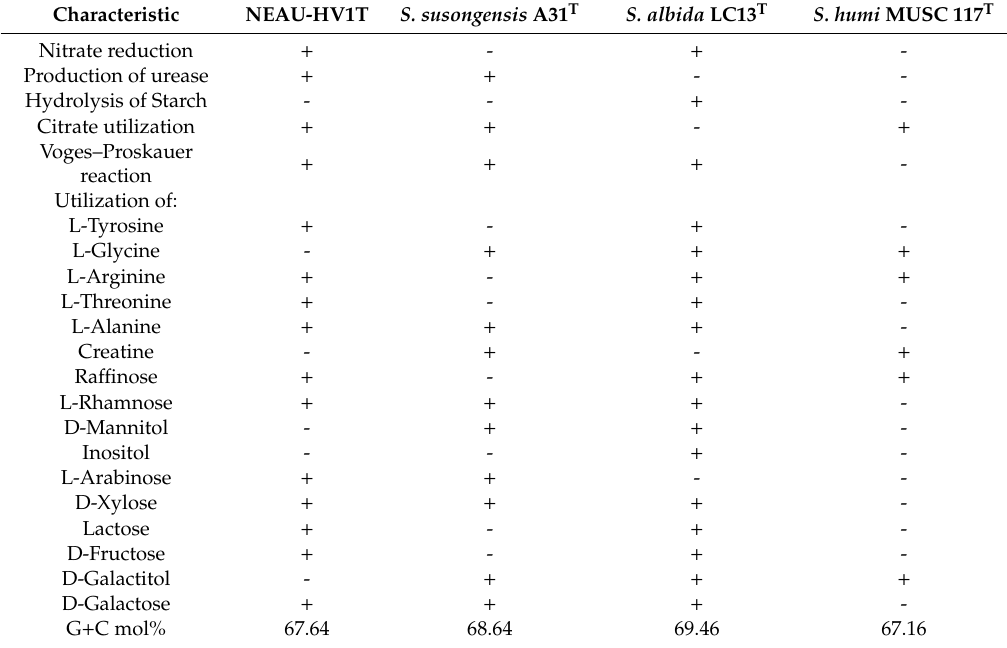
Table 1. Di ff erential characteristics between strain NEAU-HV1 T and closely related members of the genus Sinomonas .